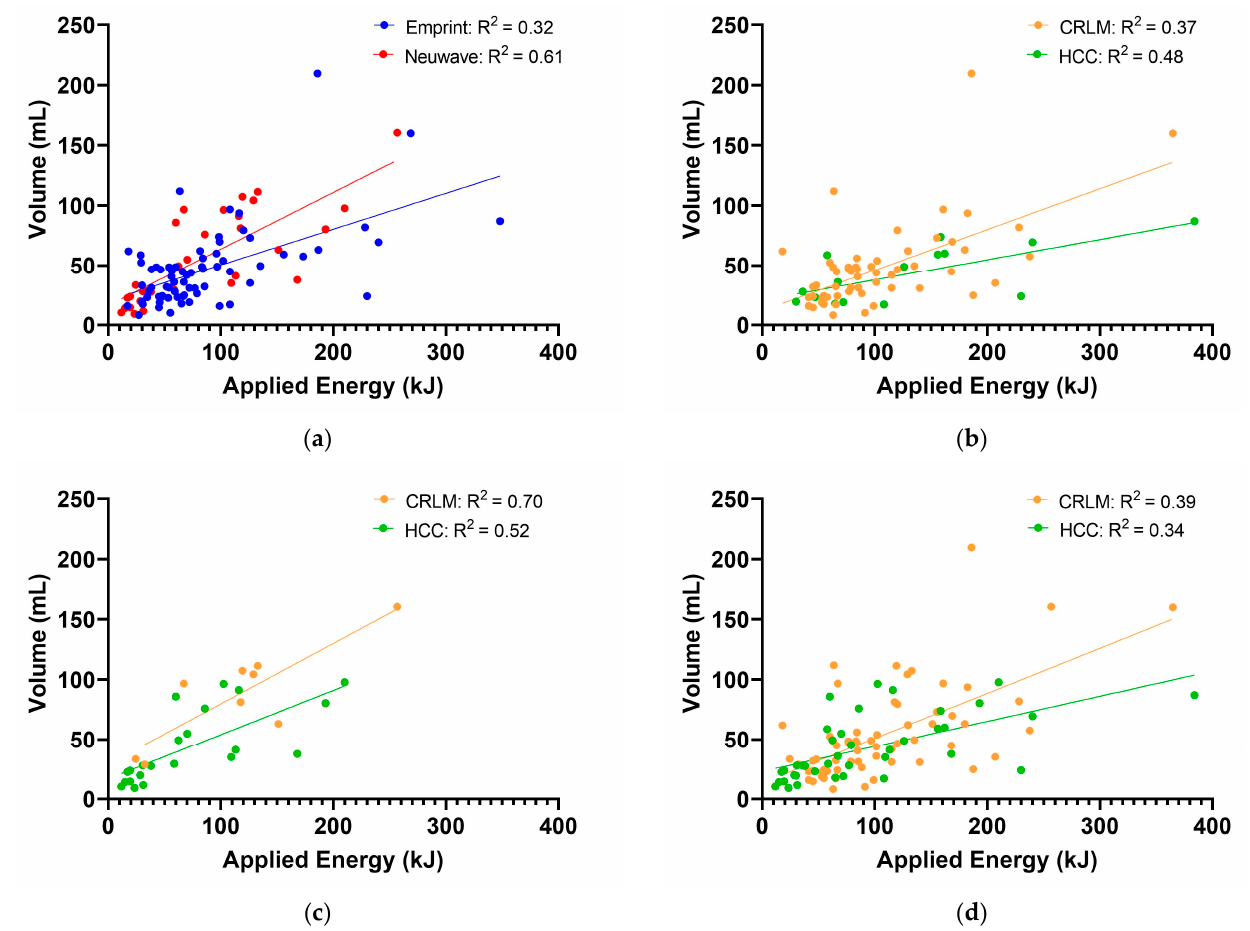
Figure 2. Correlation between applied energy and ( a ) ablation zone volume grouped by the two ablation devices; ( b ) ablation zone volume obtained with Emprint device grouped by tumour type; ( c ) ablation zone volume obtained with Neuwave device grouped by tumour type and ( d ) ablation zone volume grouped by the two tumour types. HCC = hepatocellular carcinoma; CRLM = colorectal liver metastasis.